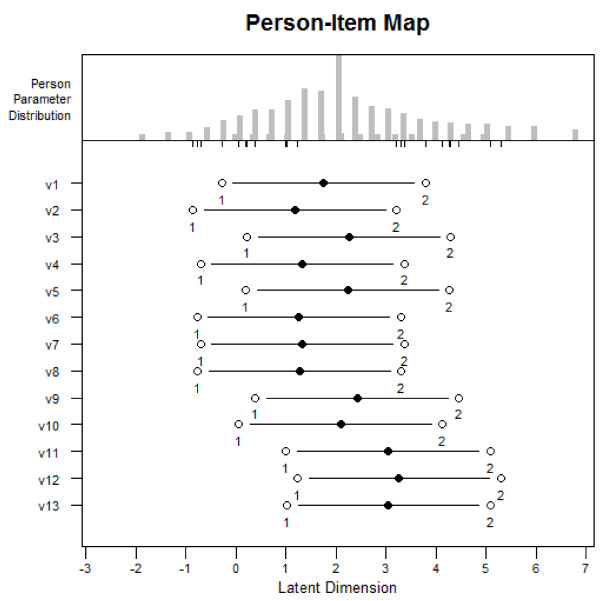
Person item-map.